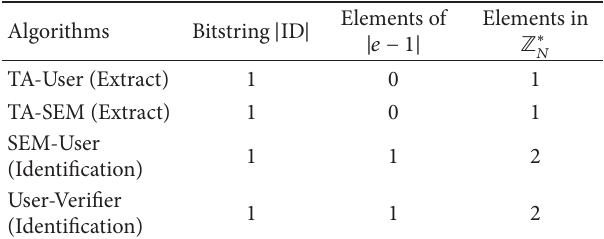
Table 4: Communication costs between algorithms for the BNN- SM-IBI scheme.